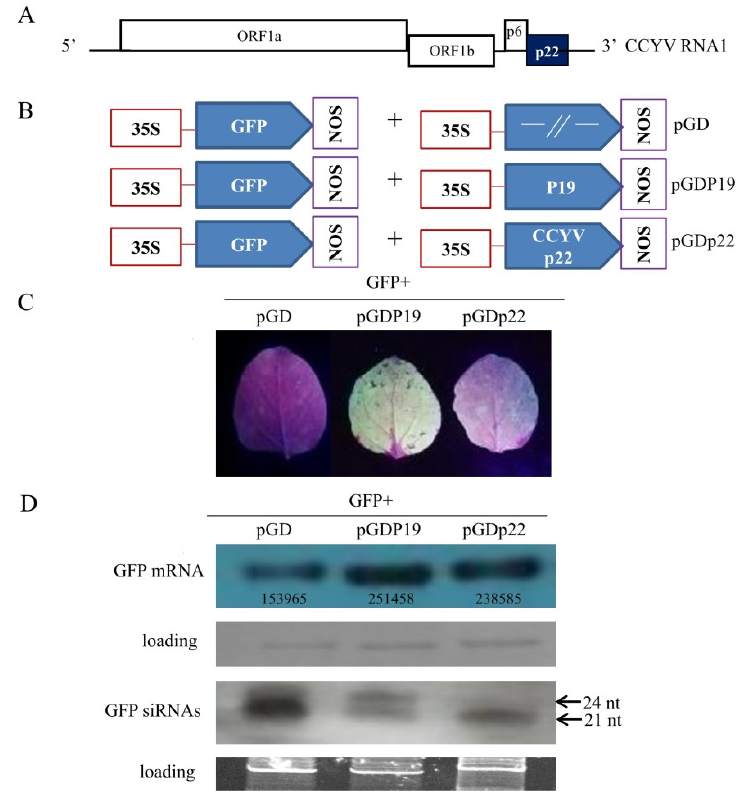
Figure 1. Cucurbit chlorotic yellows virus (CCYV) p22 suppresses RNA silencing of green fluorescent protein (GFP) in wild-type Nicotiana benthamiana . ( A ) Schematic representation of the genomic organization of CCYV RNA1. ( B ) Nicotiana benthamiana leaves infiltrated with Agrobacterium harboring GFP in combination with pGD empty vector, pGDP19, or pGDp22. ( C ) Ultraviolet light image taken 4 days post-infiltration (dpi). ( D ) Northern blot analysis of GFP mRNA and siRNA extracted from agroinfiltrated zones at 4 dpi. Ethidium bromide staining of rRNA and tRNA was used as